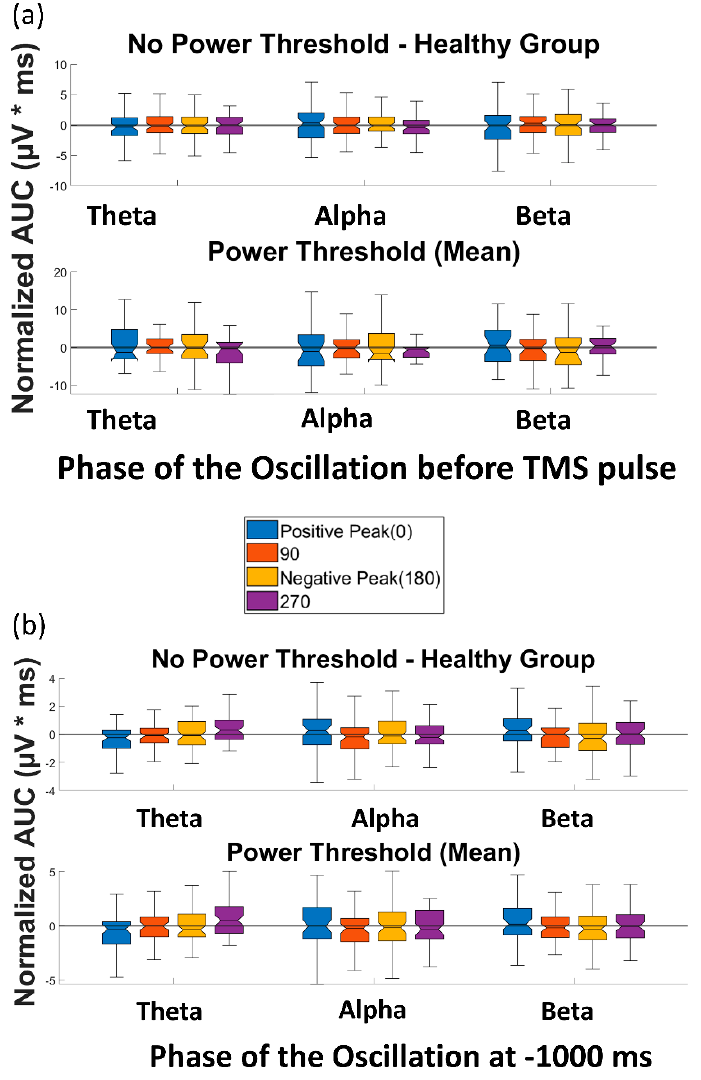
Figure 5. Effect of phase of ongoing EEG oscillation on single-trial TMS-EEG response. ( a ) Mean rectified TMS-evoked EEG activity, measured by normalized AUC (TMS) , for different phases of positive peak, 90°, negative peak, and 270° over the three frequency bands of theta, alpha, and beta before and after the power threshold (mean power) is applied. ( b ) Comparison of the normalized area under the curve for the control condition (AUC (Control) ) for different phases of positive peak, 90°, negative peak, and 270° over the three frequency bands of theta, alpha, and beta before and after the power threshold (mean power) is applied. None of the comparisons reached the significance level.